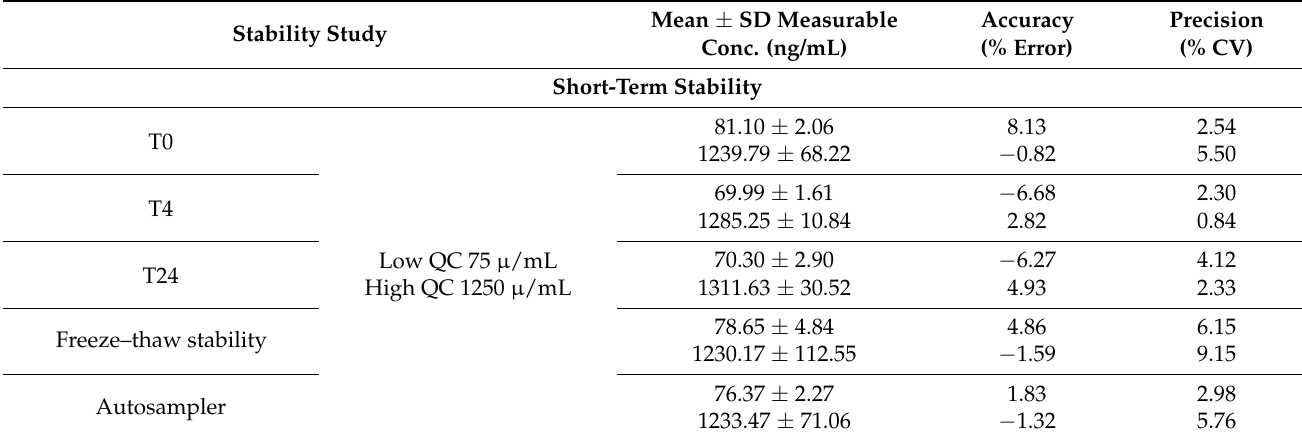
Table 5. Stability test of glipizide in spike